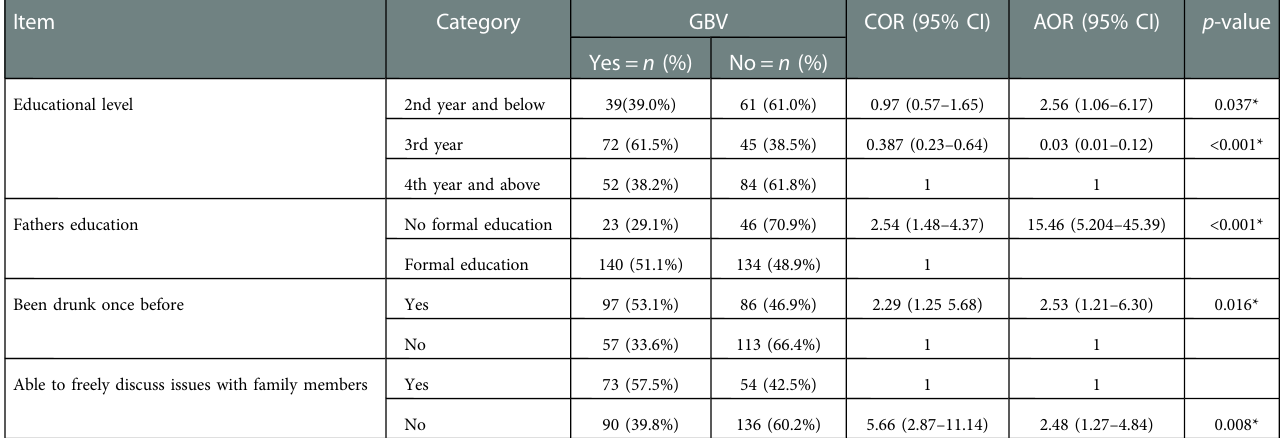
TABLE 7 Factors signi fi cantly associated with gender-based violence among female university students, southwest Ethiopia, 2021